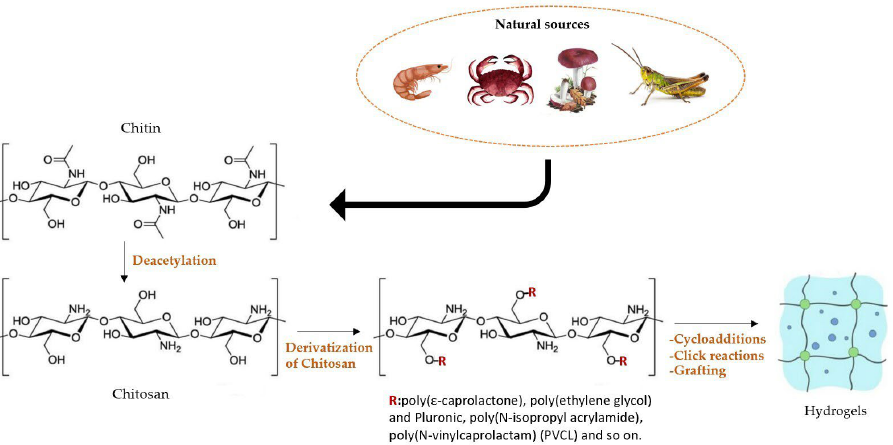
Figure 6. Chitosan molecule, derivatization and hydrogel